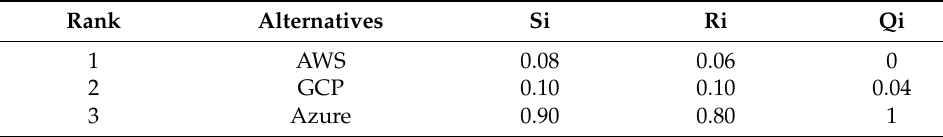
Table 4. Scenario 3: High-security, low-scale/volume